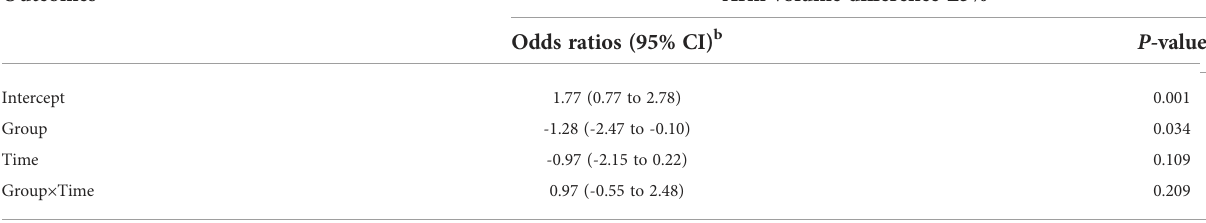
TABLE 6 Results of the binomial generalized linear mixed-effects models with a logic link function for arm volume differences. Outcomes